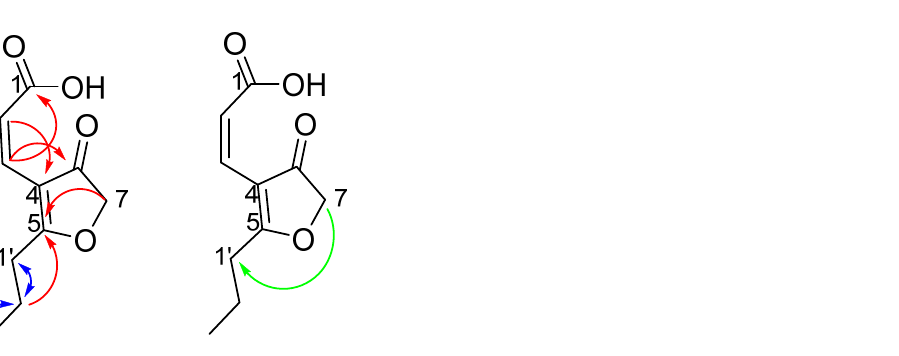
Figure 2. Sorbifuranone A ( 7 ), sorbifuranone B ( 8 ), sorbifuranone C ( 9 ), with (2 Z )-cillifuranone fragments highlighted in red.